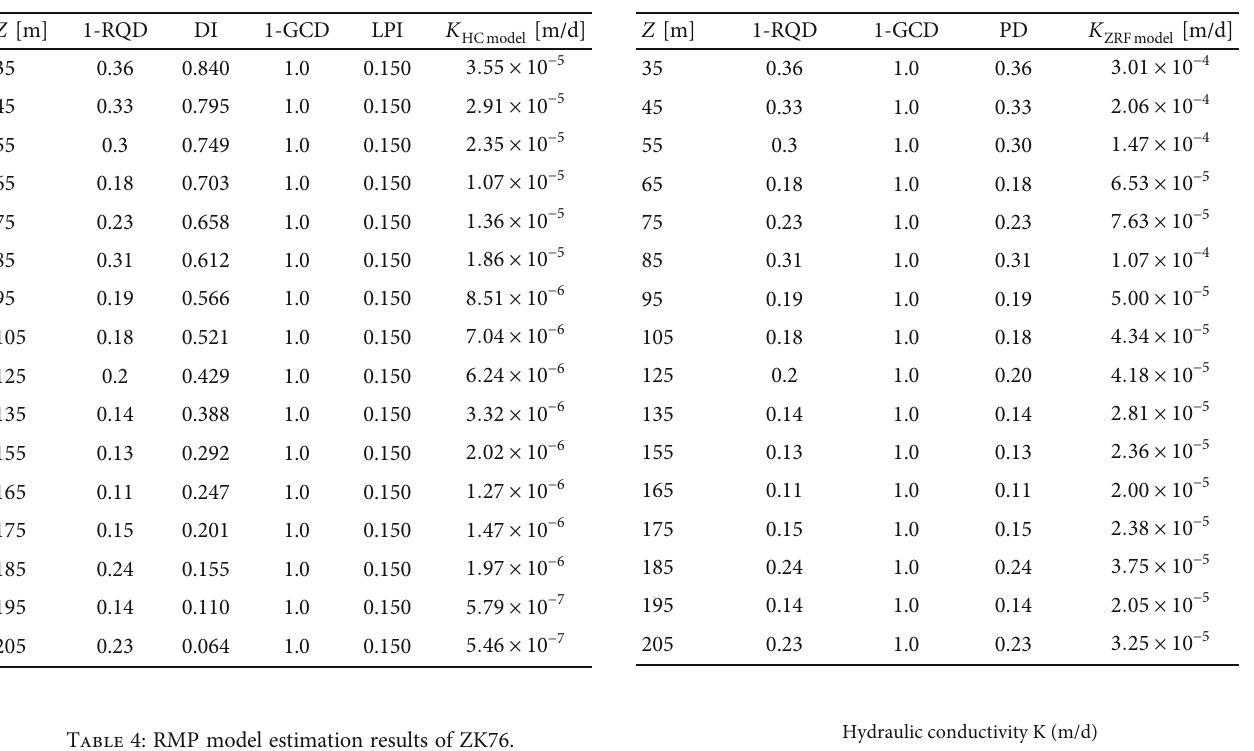
Table 5: ZRF model estimation results of ZK76. Table 3: HC model estimation results of ZK76.